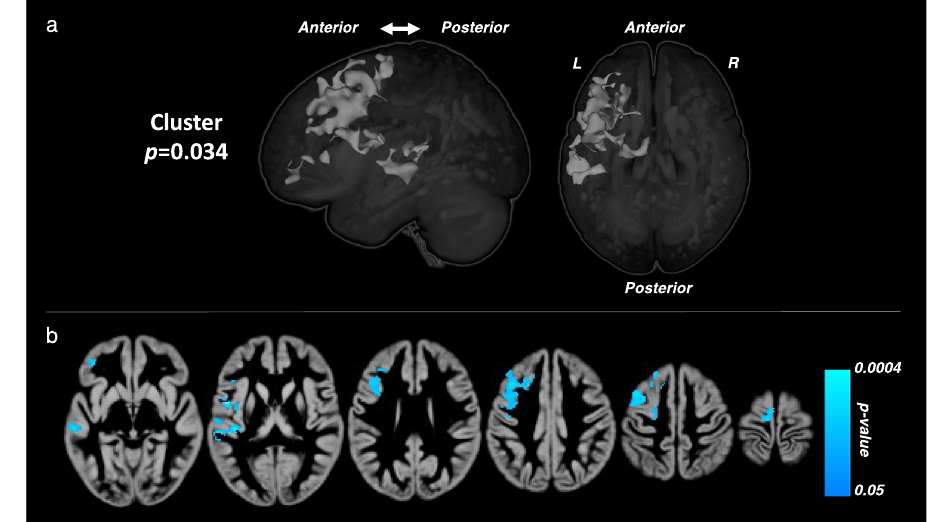
Fig. 3 | Longitudinal differences in whole-brain gray matter between groups. Brainmapsresultingfromvoxel-basedmorphometryanalysisshowingthelocation of signi fi cant between-group differences in regional gray matter trajectories.